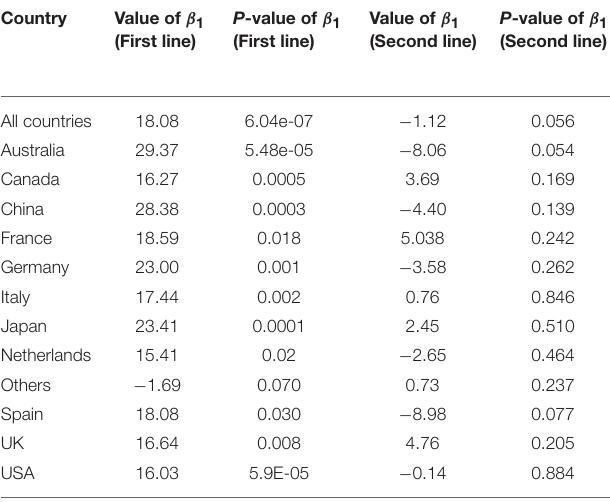
TABLE 4 | Results of a linear regression analysis for Figure 4B .